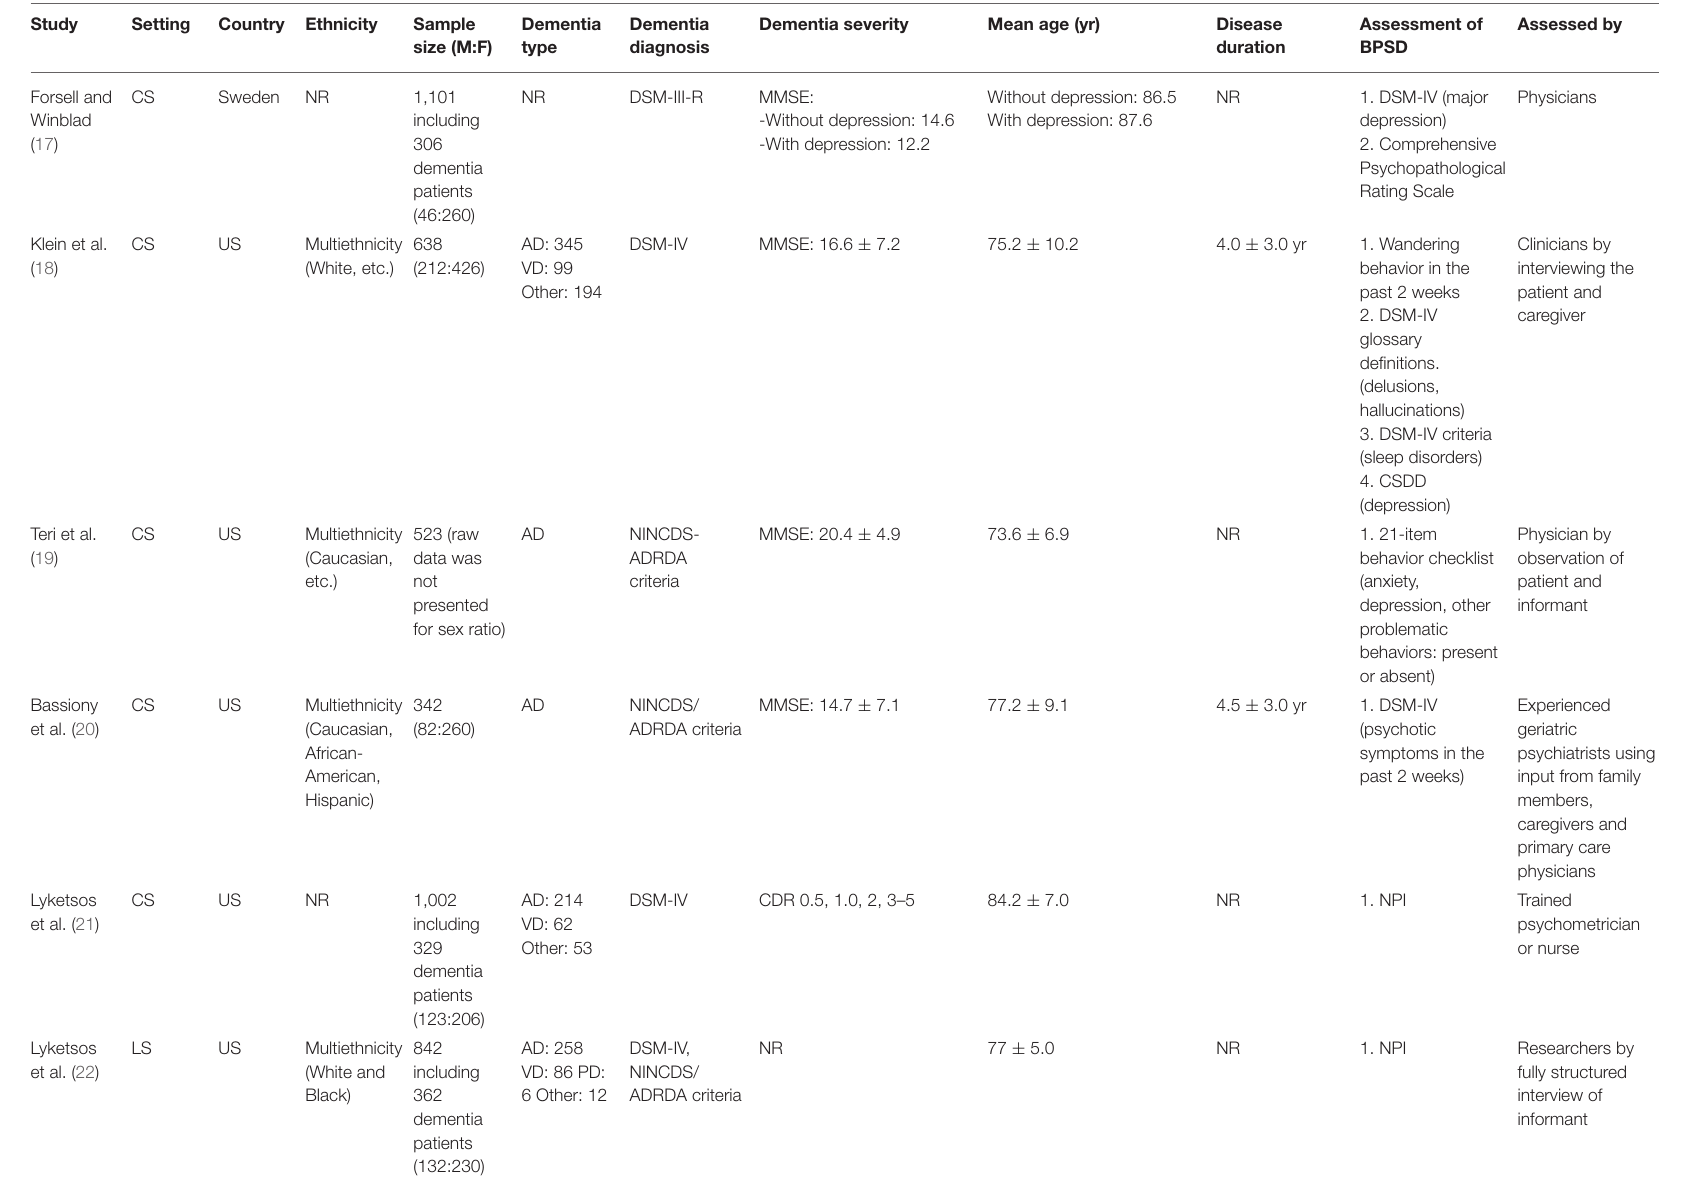
TABLE 1 | Characteristics of the included